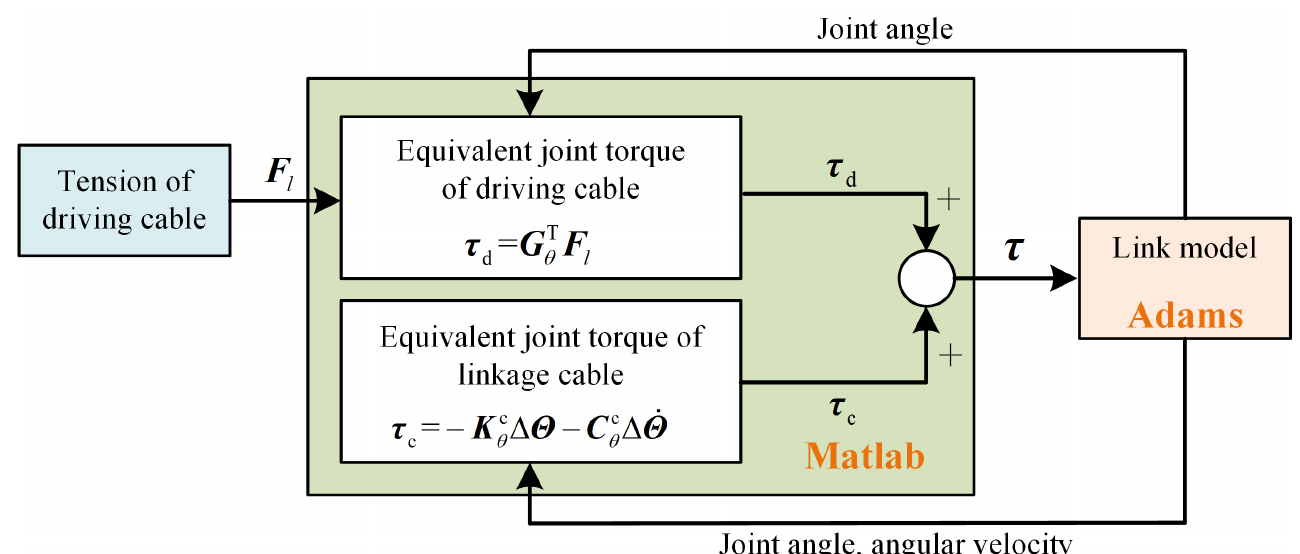
Figure 6. Co-modeling schematic.